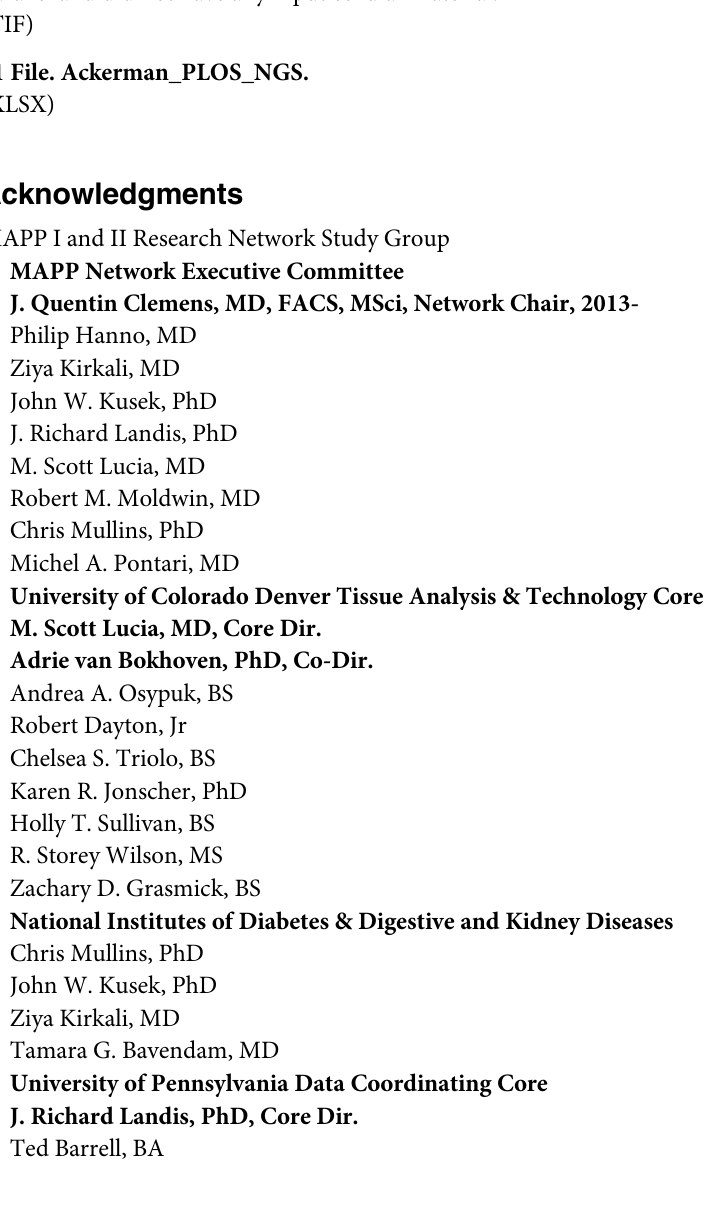
S3 Fig. Smaller volume sample processing and pooling increases DNA purification yields. Standardized urine samples from 4 subjects were pelleted and processed using the optimized purification protocol for enzymatic treatment and cell wall disruption. (A) Prior to the addi- tion of proteinase K, varying quantities of the total sample lysate were transferred to new tubes for digestion and DNA column binding. Lysate quantities � 250 μ l provided equivalent yields. (B) Prior to the addition of proteinase K, sample lysates were divided into 250 μ l aliquots. Pro- cessing of a single 250 μ l aliquot (No pooling) was compared to the results if the lysate was split into two aliquots and processed in parallel, then later pooled on either a single DNA- binding column and eluted as a single sample (1 column) or purified separately on two col- umns, eluted independently and then pooled (2 columns). Control samples were processed in parallel and did not have any input cellular